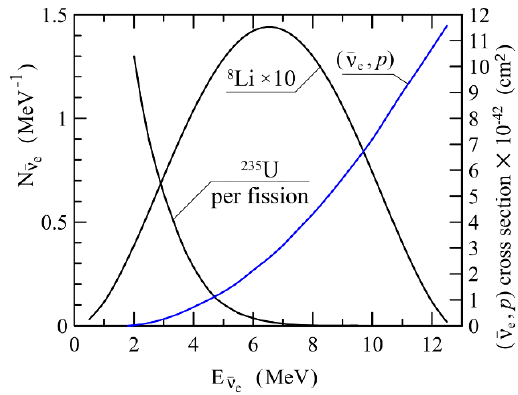
Figure 1 . Spectrum of antineutrinos from (cid:12) (cid:0) -decay of 8 Li [5] and 235 U (cid:12)ssion fragments [4] (see left axis). Cross section of ((cid:22) (cid:23) e ; p )-reaction is on the right axis